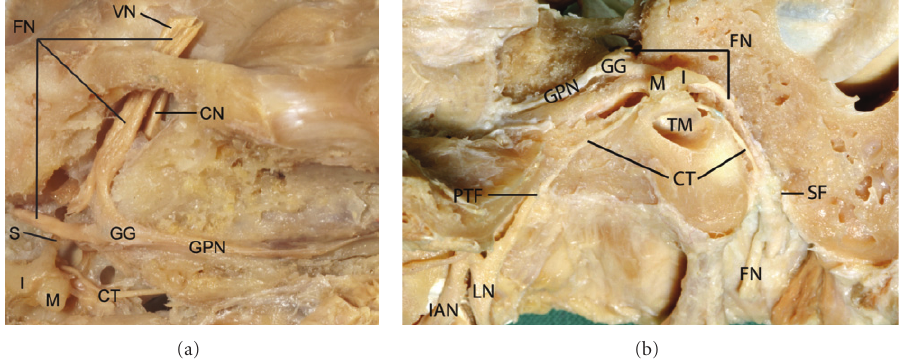
Figure 3: Dissection of the whole chorda tympani nerve from facial nerve, passing through the tympanic cavity and joining the lingual nerve. VN: vestibular nerve, FN: facial nerve, S: stapes, I: incus, M: malleus, CT: chorda tympani nerve, GG: geniculate ganglion, GPN: greater petrosal nerve, CN: cochlear nerve, PTF: petrotympanic fissure, LN: lingual nerve, TM: tympanic membrane, SF: stylomastoid foramen, IAN: inferior alveolar